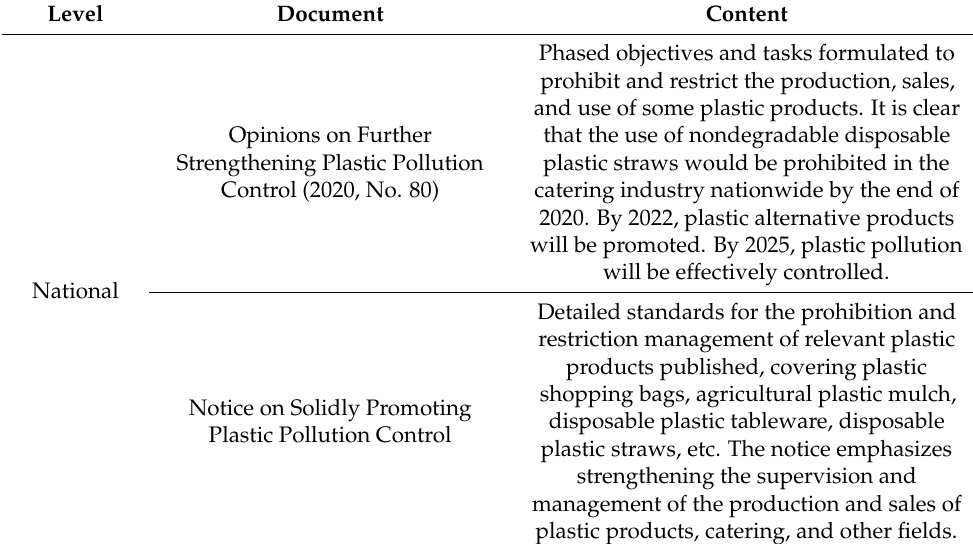
Table 1. Policies issued by the national, provincial, and municipal governments in